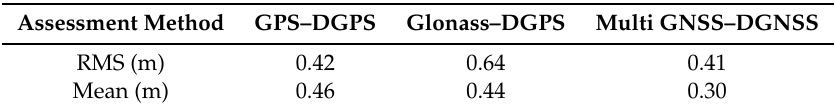
Table 3. Analysis results of position accuracy for GPS, multi-Global Navigation Satellite System (GNSS) and differential methods in Reference